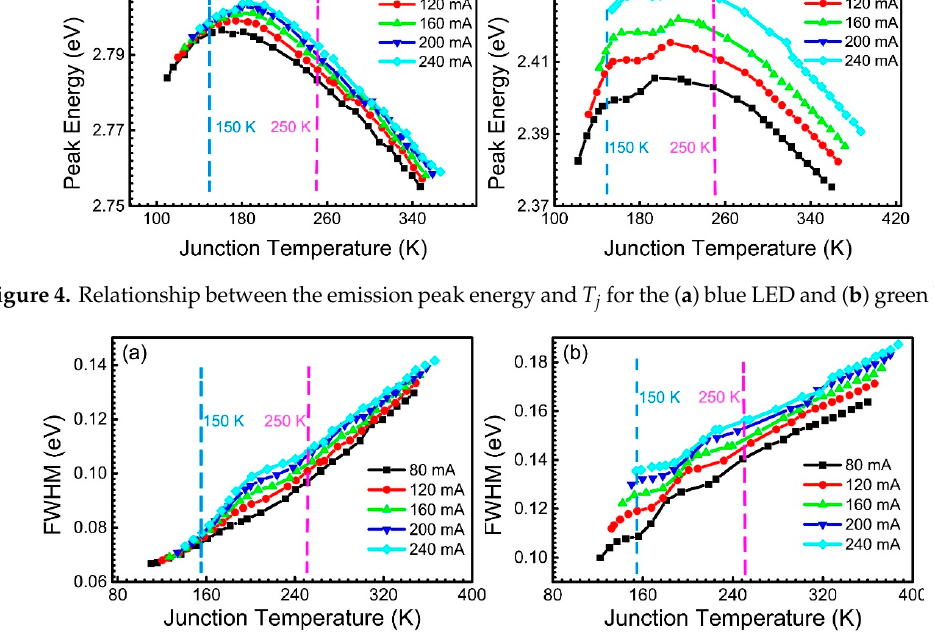
Figure 5. Relationship between the full width at half maximum (FWHM) of the EL spectra and T j for the ( a ) blue LED and ( b ) green LED.